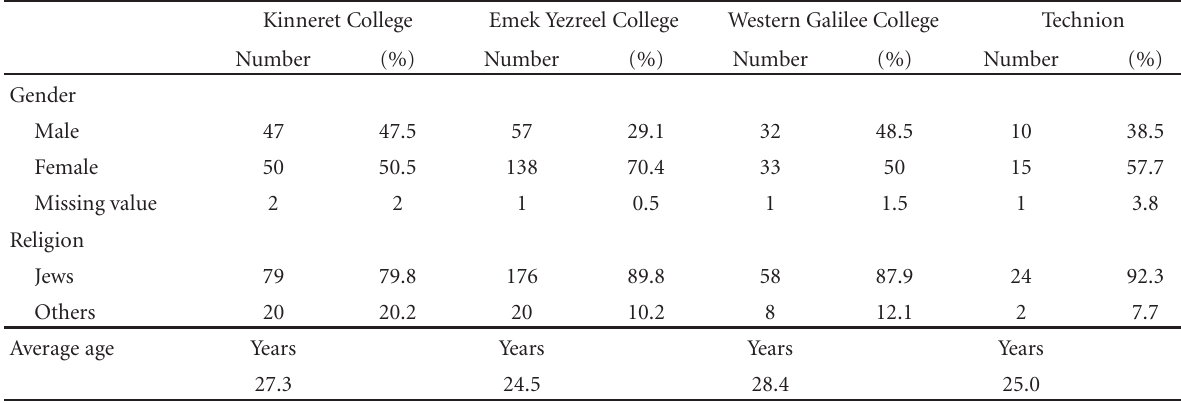
Table 7: Characteristics of the sample by institution.